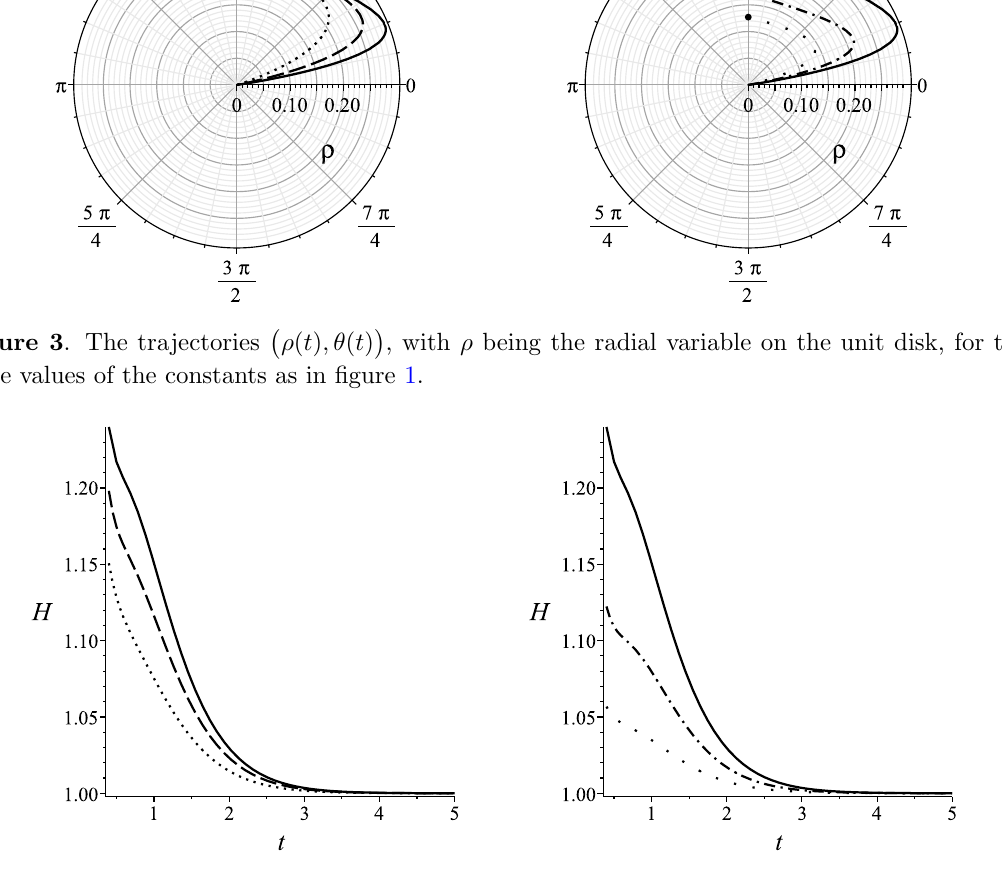
Figure 4 . The Hubble parameters H ( t ) for the same values of the constants as in (cid:12)gure